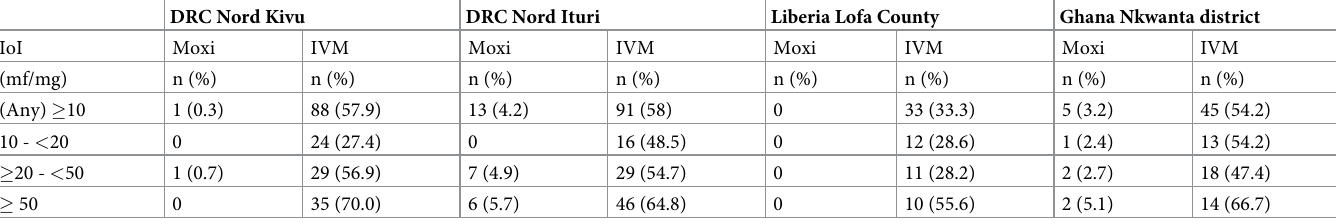
Table 6. Participants with detectable SmfD and SmfD data at 1 and 6 and/or 12 months post-treatment. DRC Nord